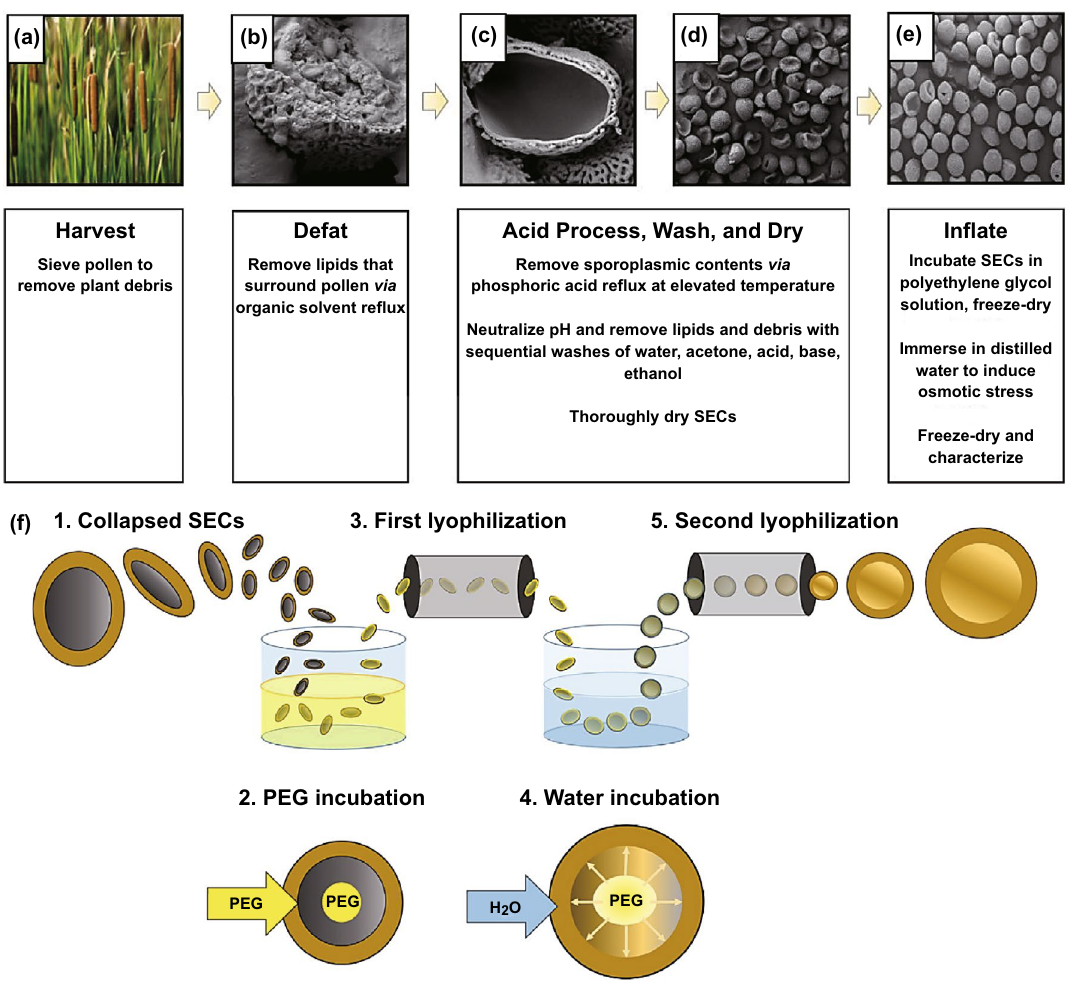
Fig. 5 a–f Sporopollenin exine capsules (SECs) extraction procedures from cattail ( Tyhphae angustfolia ) pollen grains. PEG: polyethylene gly- col. Reproduced with permission from Ref. [44]. (Color figure